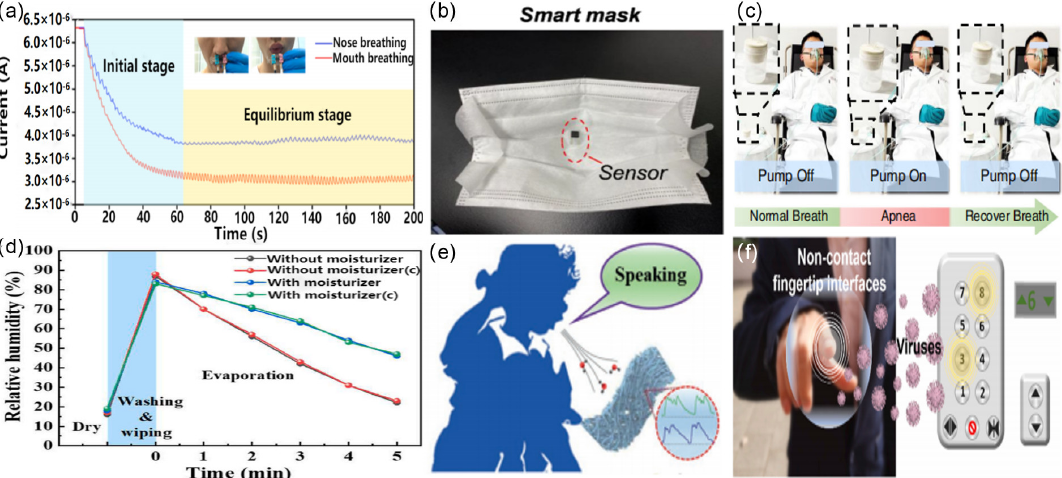
Figure 3. Applications of flexible humidity sensors: ( a ) the current signal profiles of human nose breathing and mouth breathing (reproduced with permission from [65]); ( b ) image of the applica- tion of the humidity sensor for monitoring human breath (reproduced with permission from [66]); ( c ) photos of a SAS diagnosing – treating system with an integrated CEH sensor (reproduced with permission from [67]); ( d ) a TiO 2 /CNC humidity sensor used in a moisturization experiment, in which a commercial skin moisture detector was used as a reference (marked as “C”) (reproduced with permission from [68]); ( e ) schematic illustration of MPHS for detecting exhaled air during speaking (reproduced with permission from [69]); ( f ) proof-of-concept of non-contact fingertip interfaces (reproduced with permission from [33]).